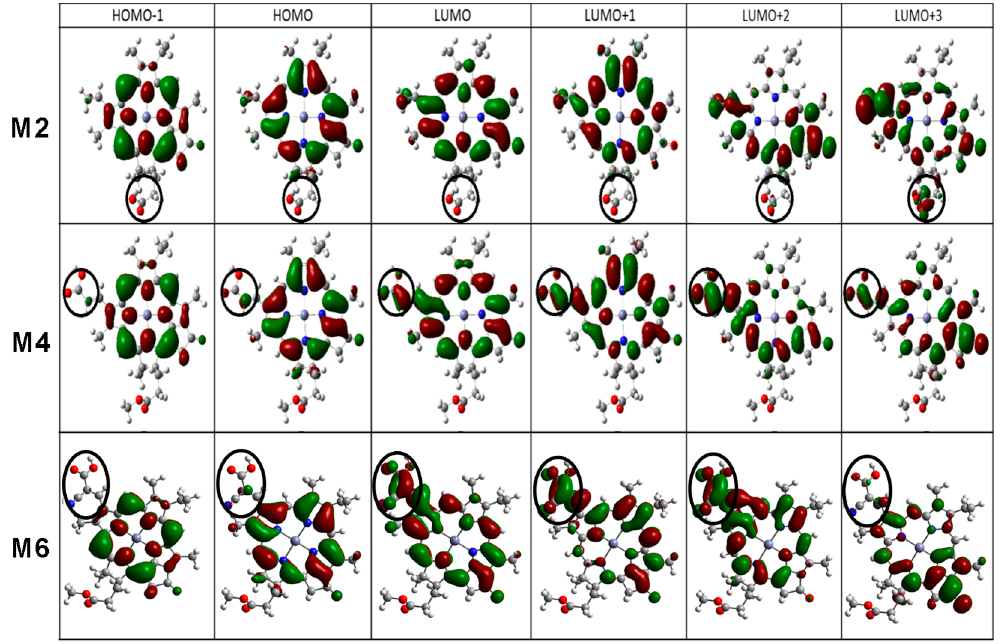
Figure 7. HOMO-1, HOMO, LUMO, LUMO + 1, LUMO + 2, and LUMO + 3 molecular orbitals for M2 (top) and M4 (middle) and M6 (bottom) dyes. The anchoring groups are circled in black.